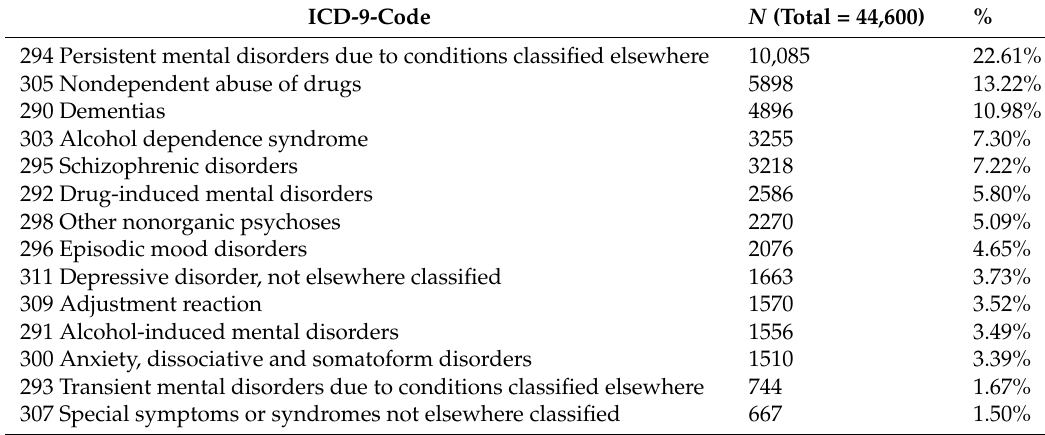
Table 2. Distribution of mental-disorder hospitalizations by ICD-9 code (principal diagnosis at discharge), Hong Kong,